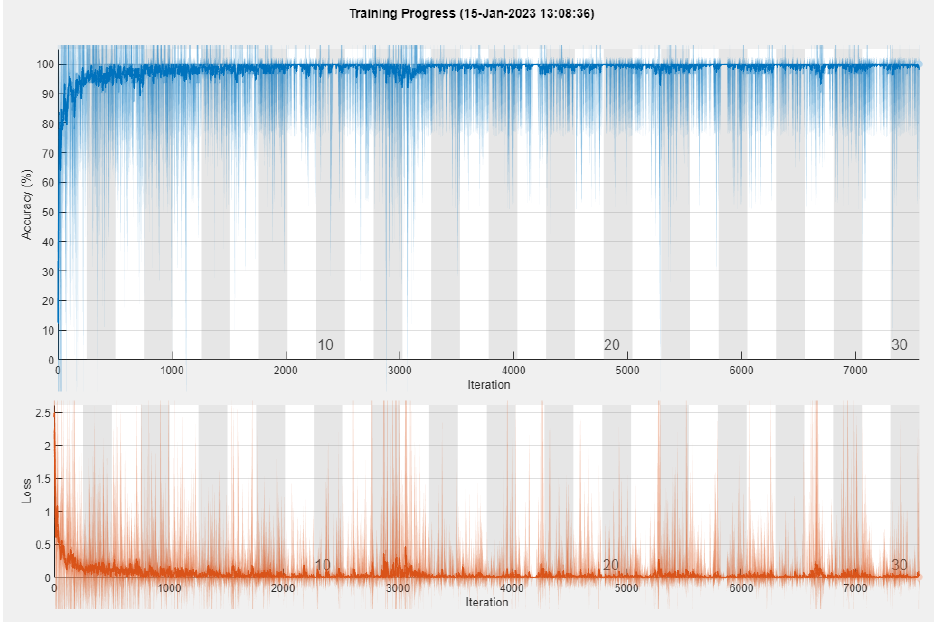
Figure 8. Training/Validation progress curves of InceptionResNetV2 for 5 fold cross